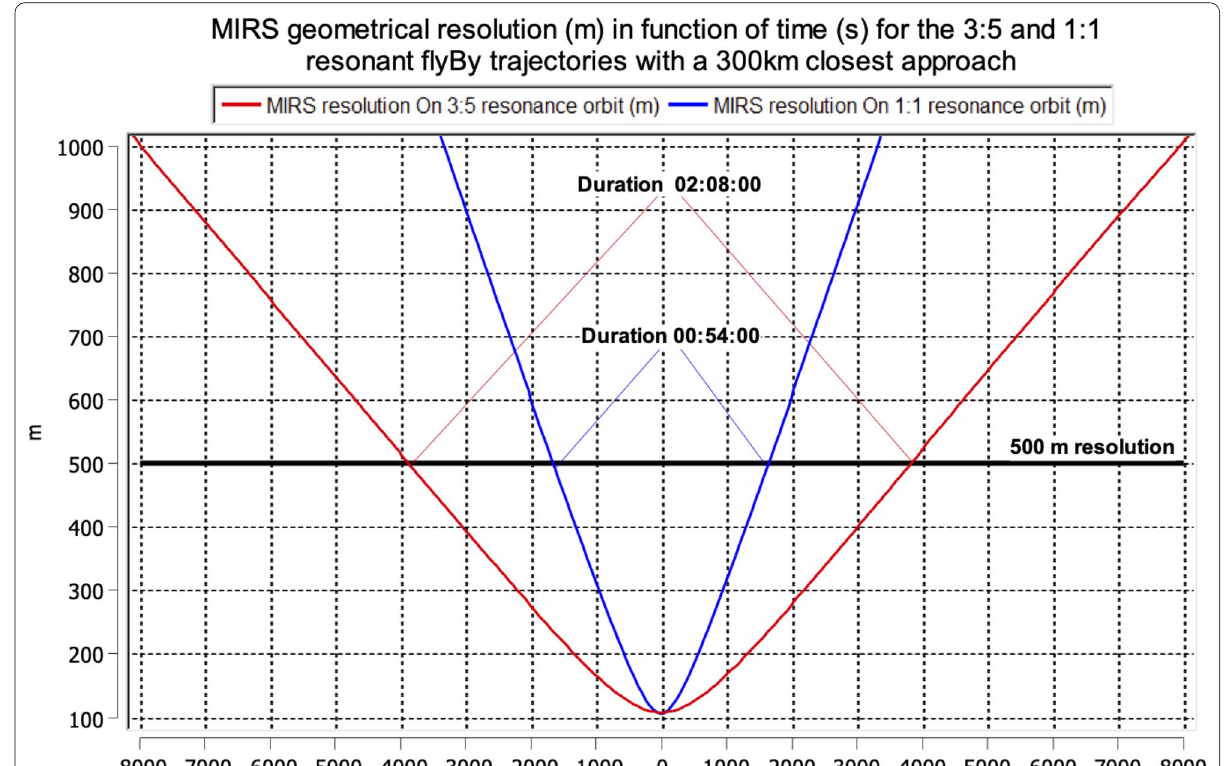
Fig. 20 MIRS geometric resolution (m) in function of time (s) for the 2 resonant flyby trajectories with a 300 km closest approach. Red line shows 3:5 and blue shows 1:1 resonance orbit. The spacecraft is closest to Deimos at t